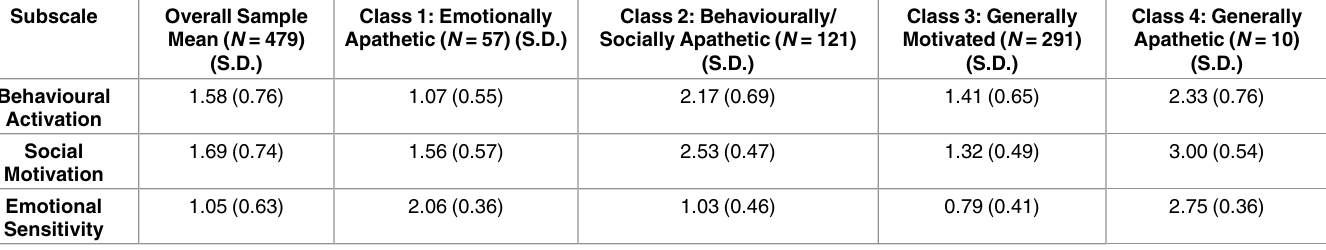
Table 7. Overall sample means and AMI profile conditional response means on the AMI Behavioural Activation, Social Motivation and Emotional Sensitivity subscales.